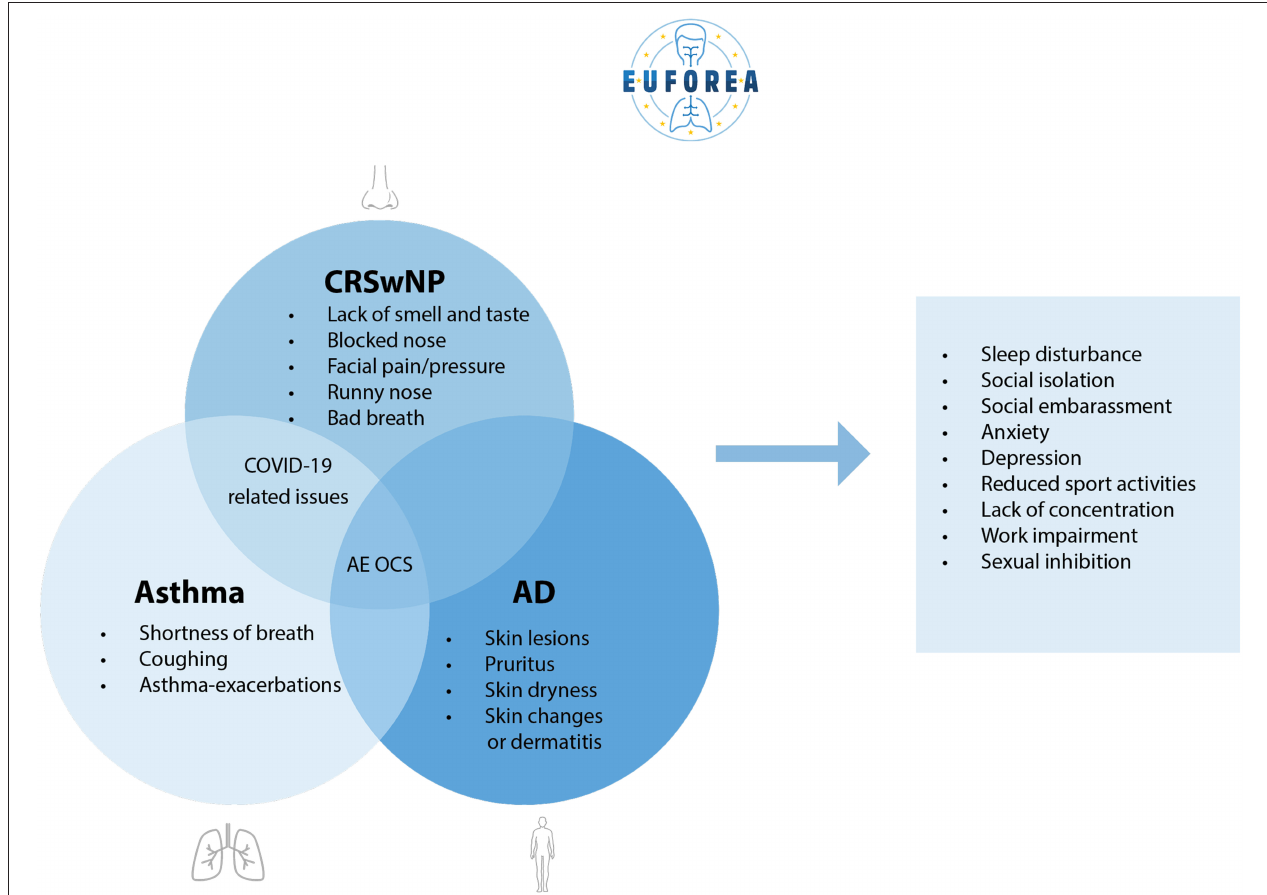
FIGURE 1 | Summary of the burden of Type 2 inflammatory conditions (AD, asthma and CRSwNP), statements ordered by number of times